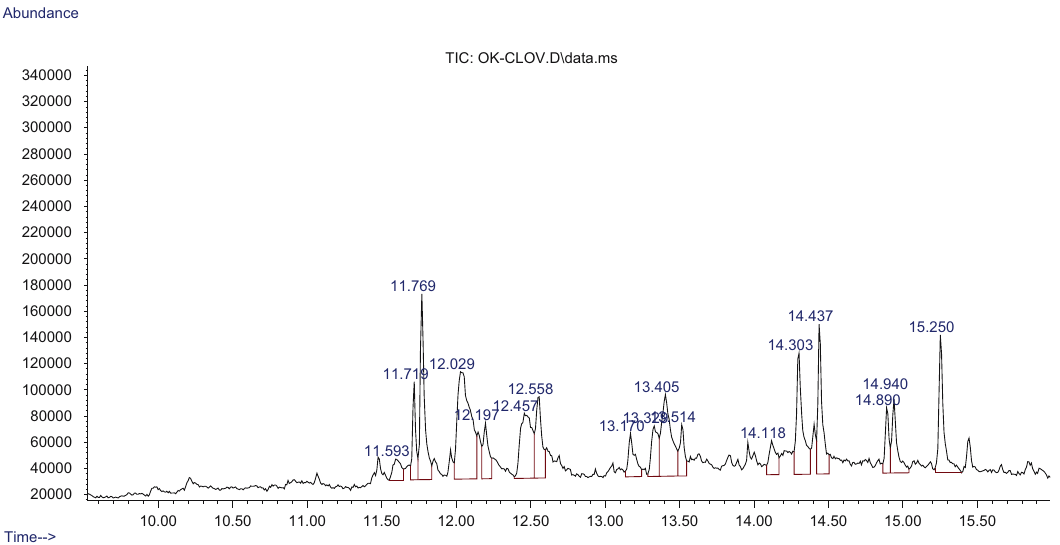
Figure 2: The analysis of the chemical contents of the Rumex vesicarius seed extract by the chloroformed